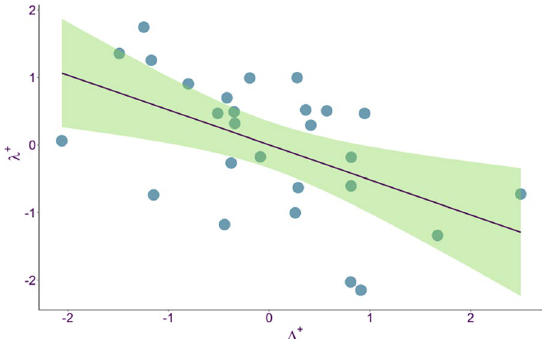
Fig. 3 Scatter plots of the relationship between taxonomic distinctness (Δ + ) and the index of variation in taxonomic distinctness (λ + ) (multiple R 2 0.267, r 0.517, p < 0.05) of spider community in = = − the 27 sites studied along the Ganga